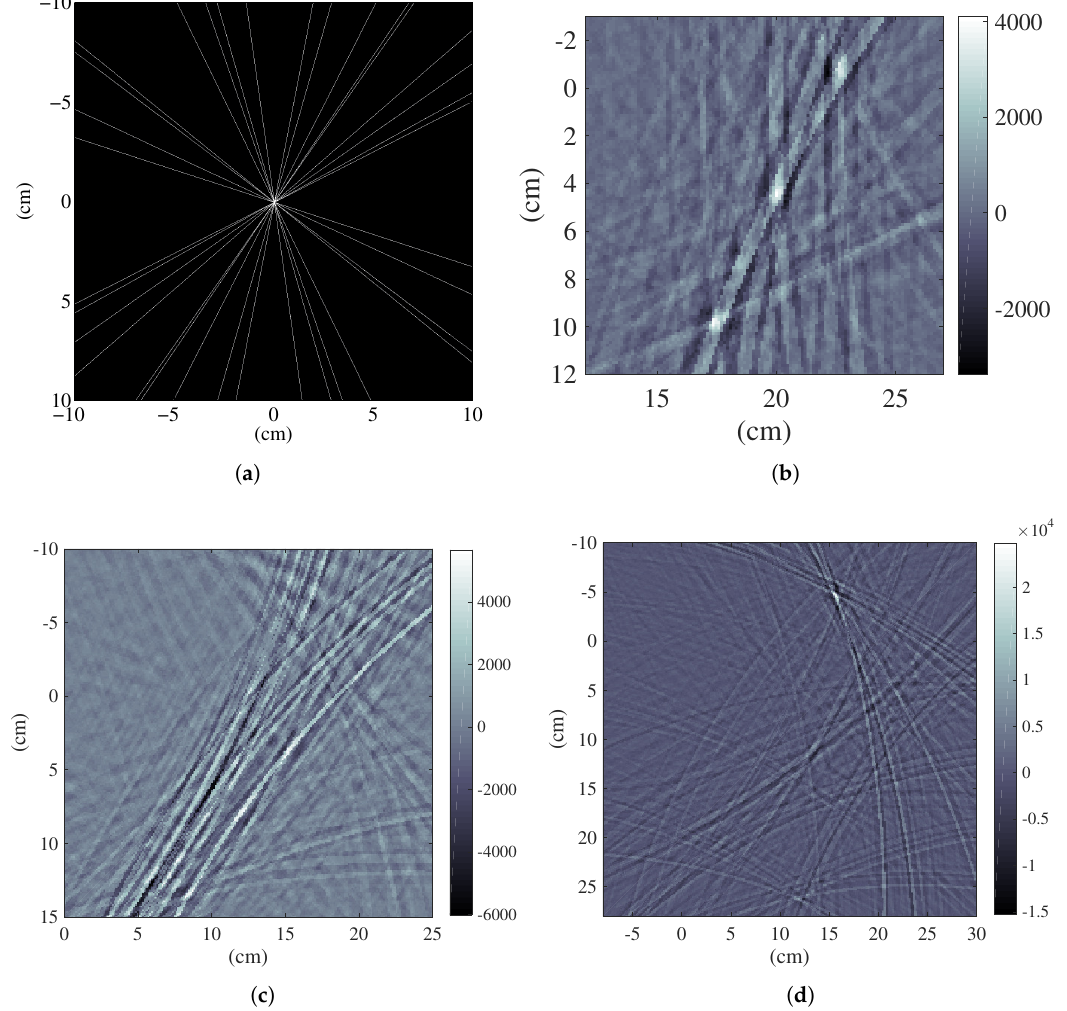
Figure 14. Reconstructed radar images generated using 5% of the measurements; ( a ) Angle of measurements; ( b ) The pins; ( c ) The pencil case; ( d ) The cylindrical pencil vase